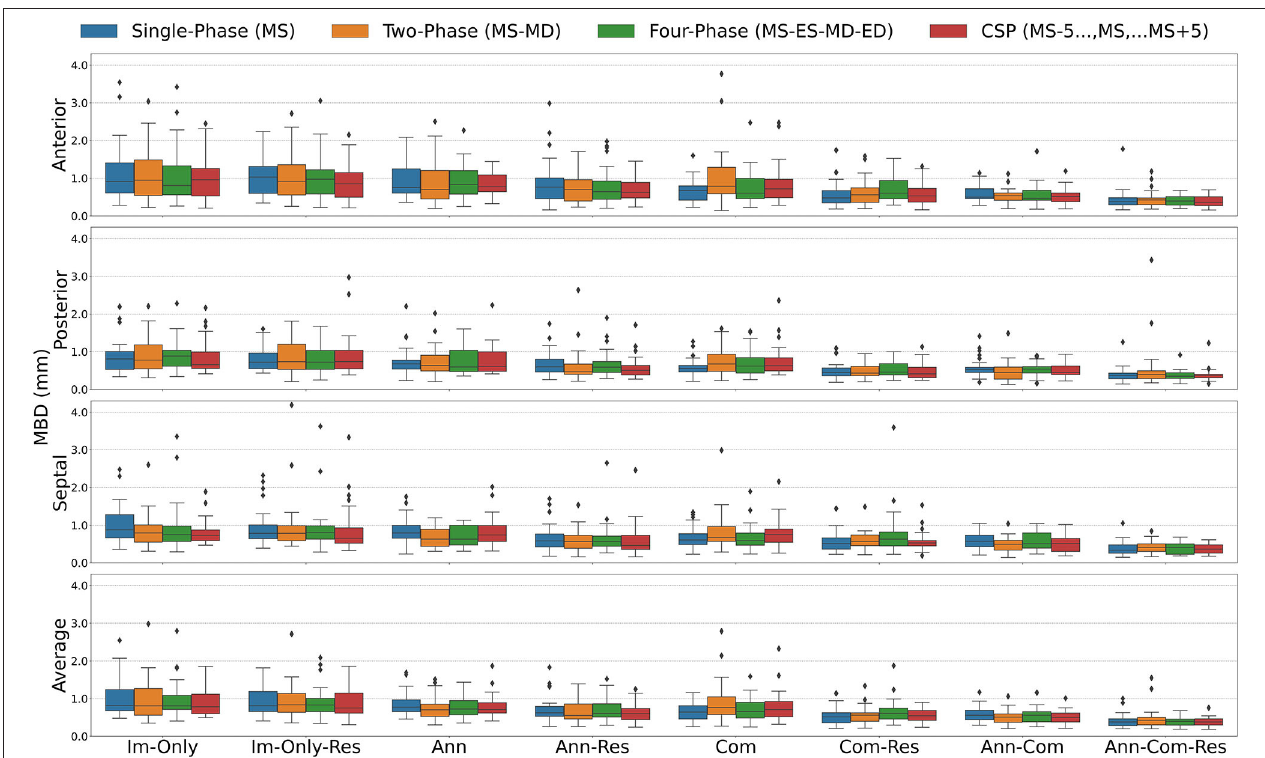
FIGURE 6 | Mean Boundary Distance (MBD) for all stages combined for all Input Frame Combinations (Single-Phase, Two-Phase, Four-Phase and CSP) and all Binary Combinations of the Annular Curve Input (Ann), Commissural Landmarks Input (Com) and Resampling (Res). Segmentation accuracy is presented for individual leaflets (anterior, posterior, septal) and the individual leaflet average. The boxes represent median MBD with IQR. The whiskers present 1.5*IQR past the low and high quartiles. The diamonds indicate outliers.